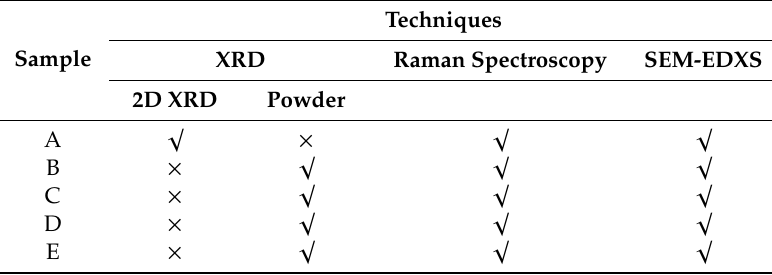
Table 2. Analytical techniques adopted on each